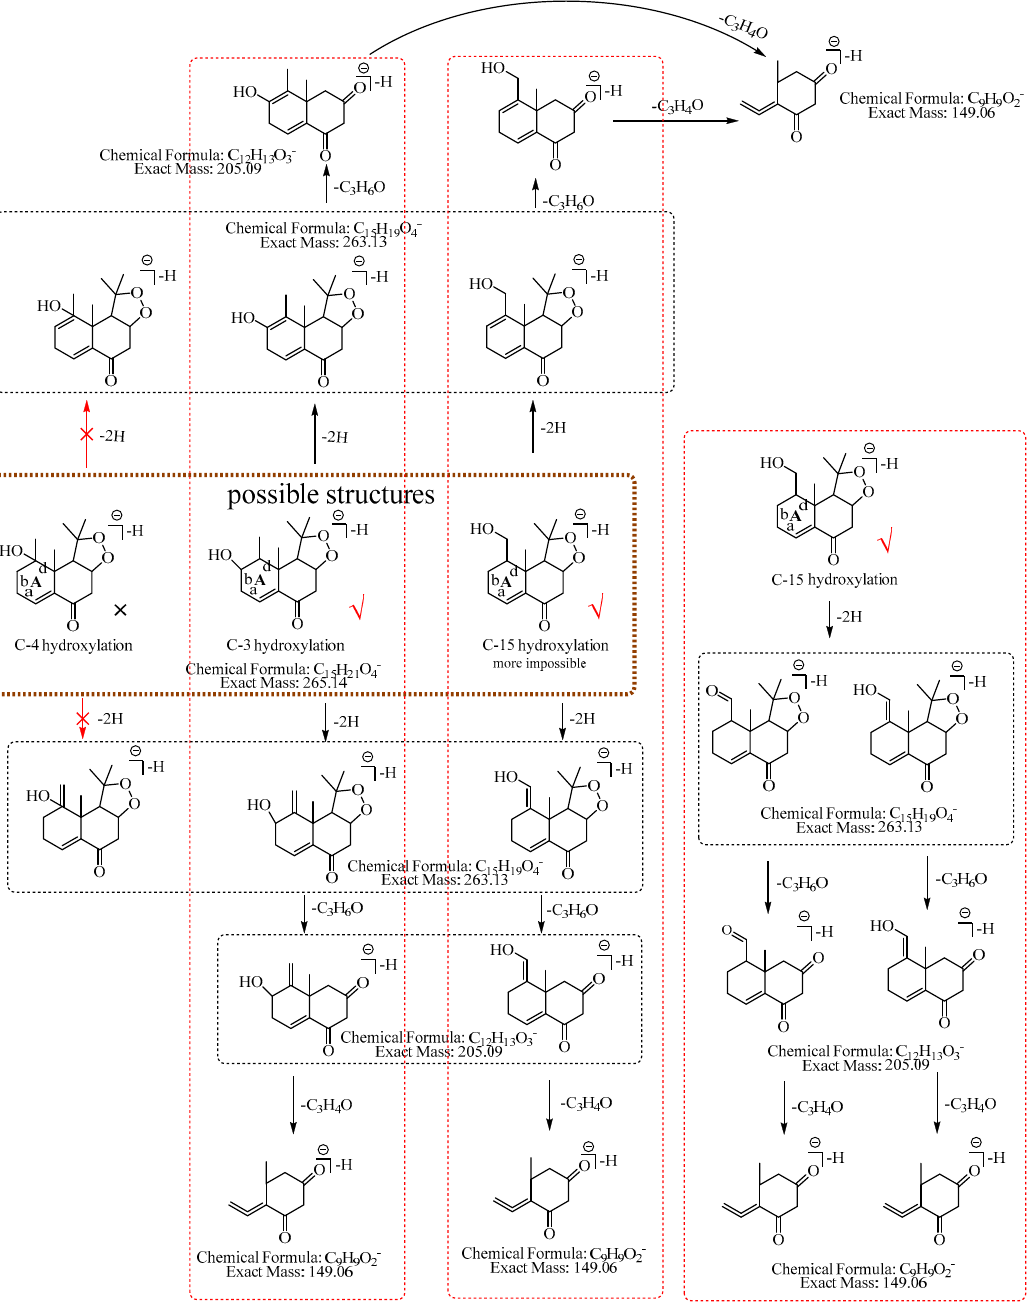
Figure 10. The proposed fragmentation pathways of M8 (3-hydroxyl nardosinone or 15-hydroxyl nardosinone). “ √ ” represents the possible structure. “×” represents the impossible structure. The brown rim represents the possible structures; A represents the hexatomic ring. The red rims represent the most possible fragmentation pathways.